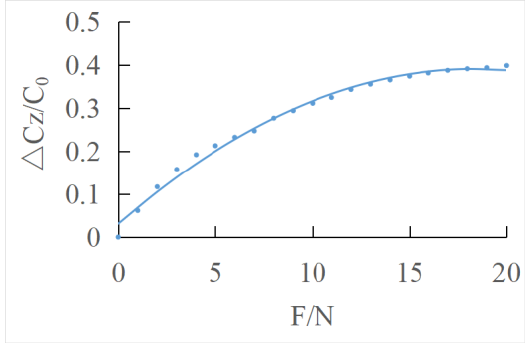
Figure 11. Least squares fitting the output characteristic curve of normal force direction.